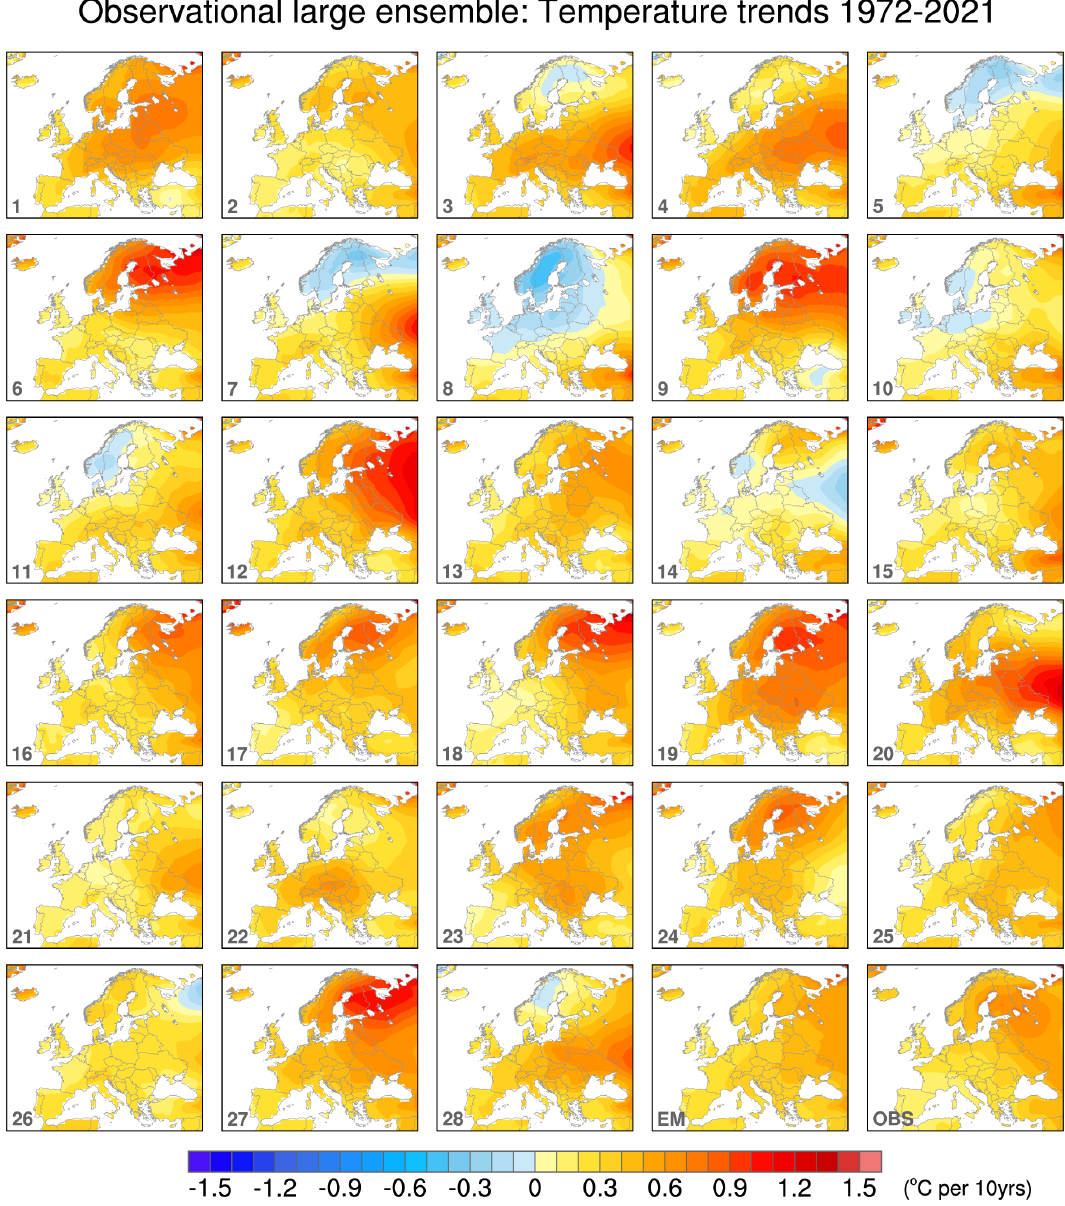
Figure 3. As in Fig. 1 but for the observational large ensemble of McKinnon and Deser (2018), with the ensemble mean from the 100- member CESM2 large ensemble. See text for